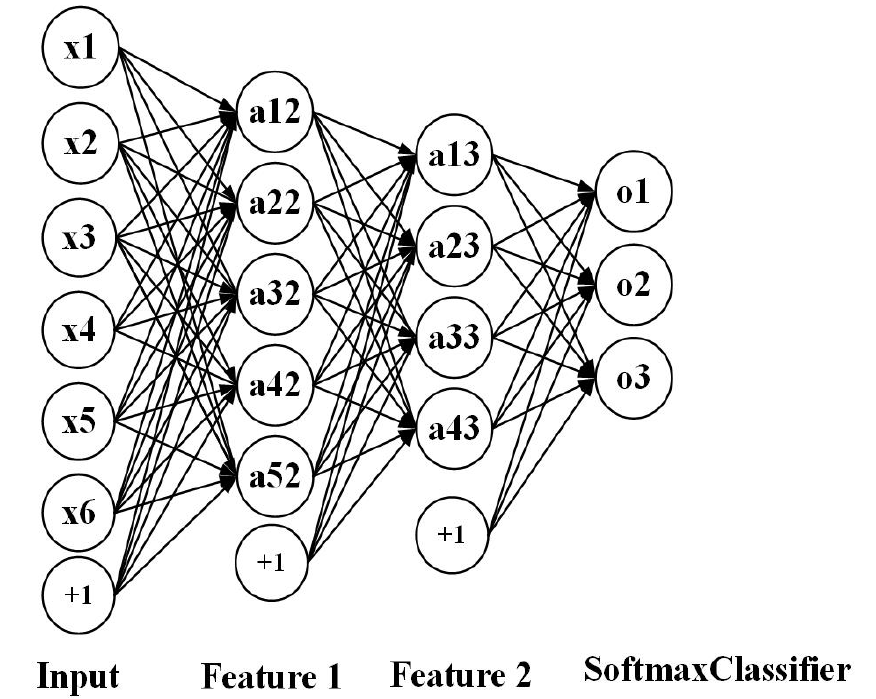
Figure 9. The encoder of deep Stack AutoEncoder (SAE) with softmax classifier.